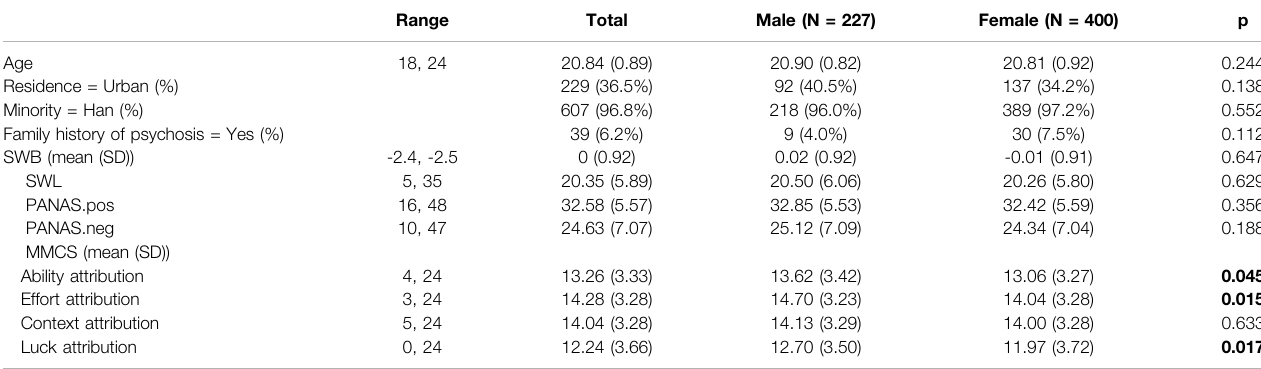
TABLE 2 | Characteristics of the study population